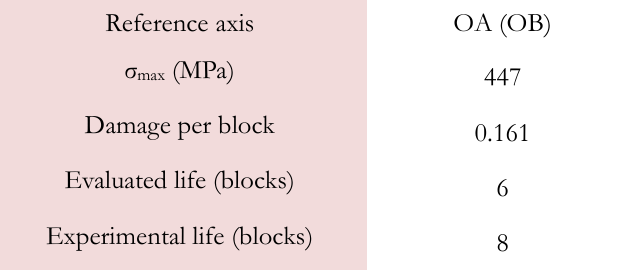
Table 2: Life evaluation under random